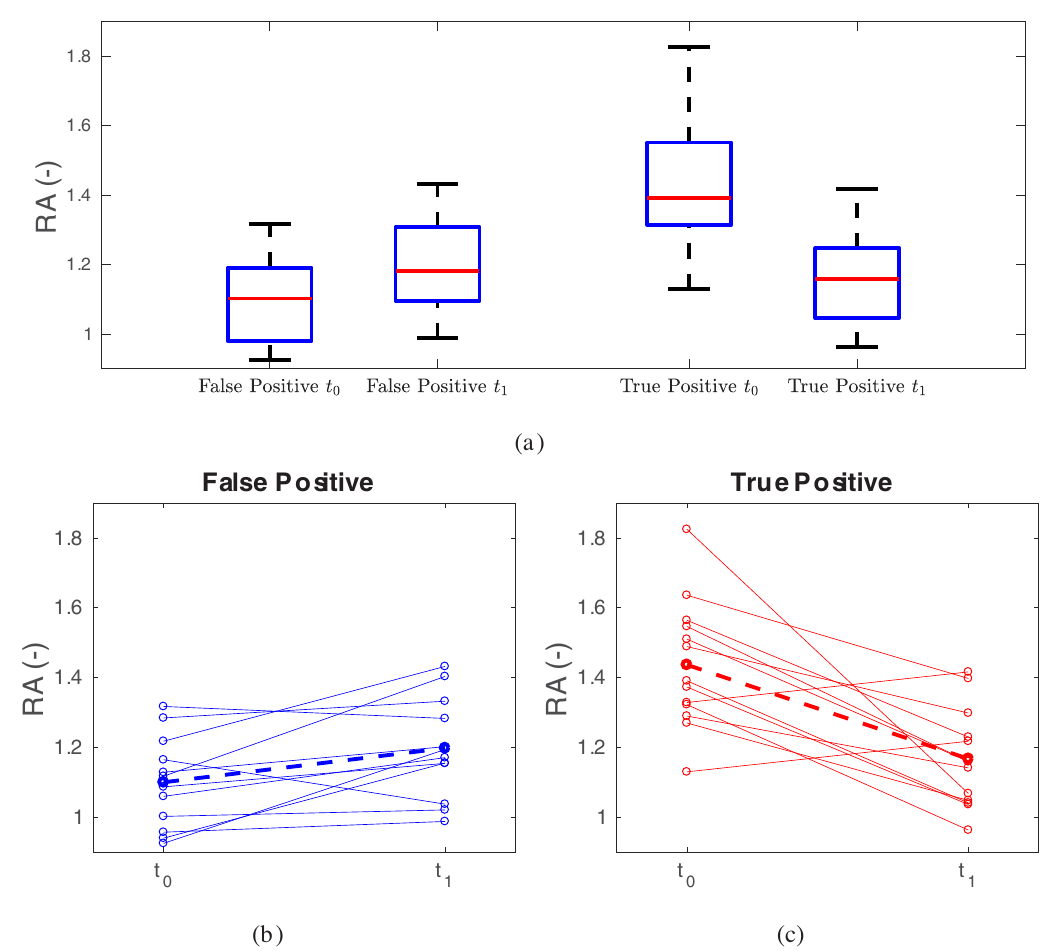
Fig 3. Summary of RA values at time points t 0 (pre-treatment) and t 1 (post-treatment). (a) Boxplots. (b) False positive cases and (c) true positive cases. The dashed line indicates the average trend.